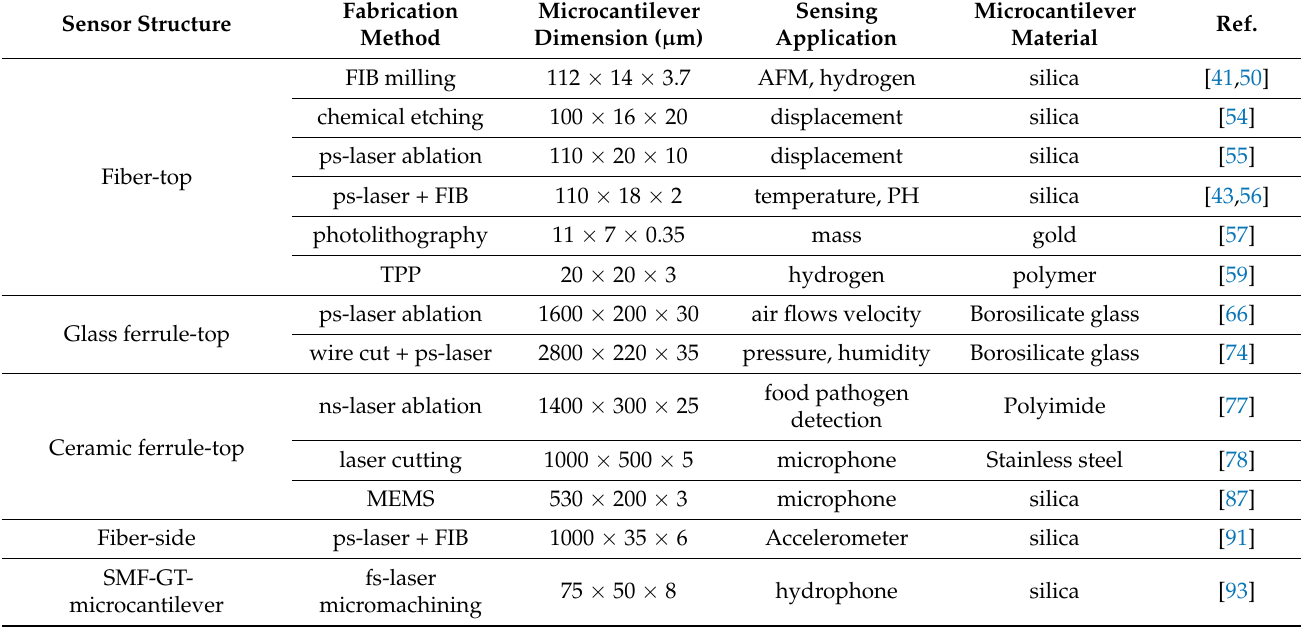
Table 1. Comparison of the optical fiber probe microcantilever